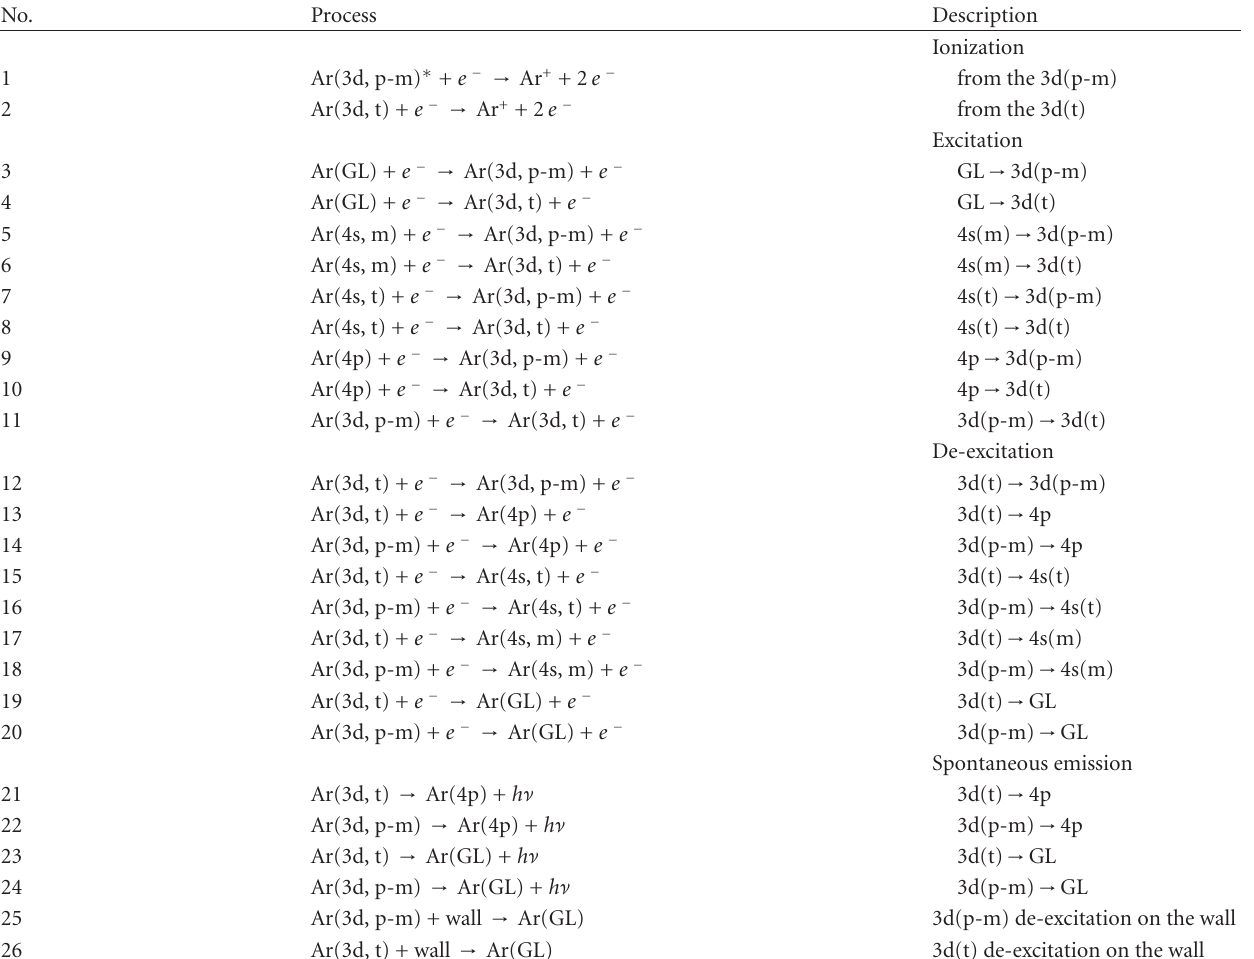
Table 3: List of the processes involving Ar I 3d levels.